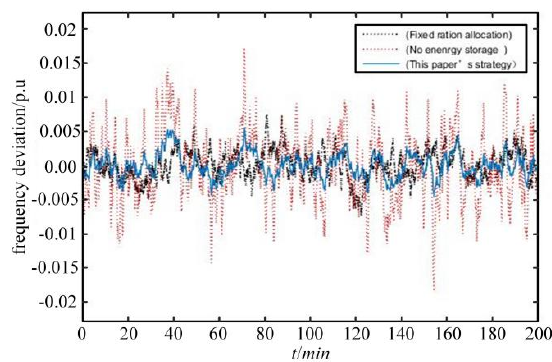
Figure 15. Frequency deviation.